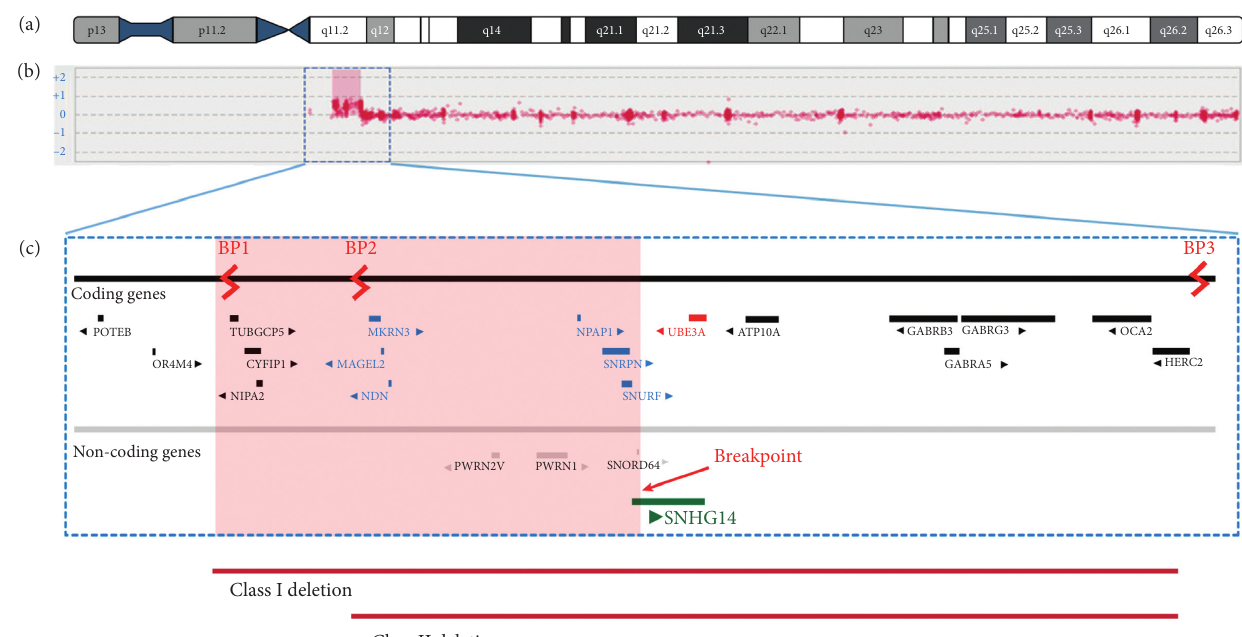
Figure 4: Microarray-based comparative genomic hybridization (aCGH), x3, showing the breakpoints where the duplication